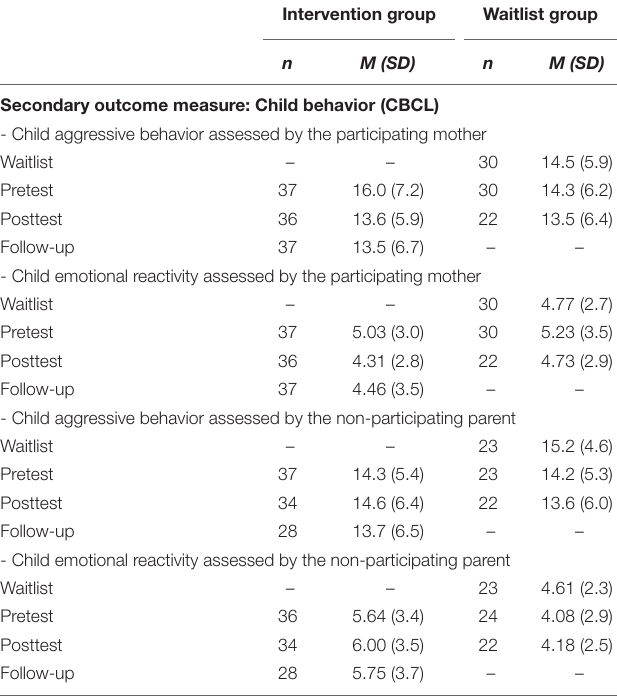
TABLE 5 | Mean and standard deviations for secondary outcome measures regarding child behavior at each measurement point. Intervention group Waitlist